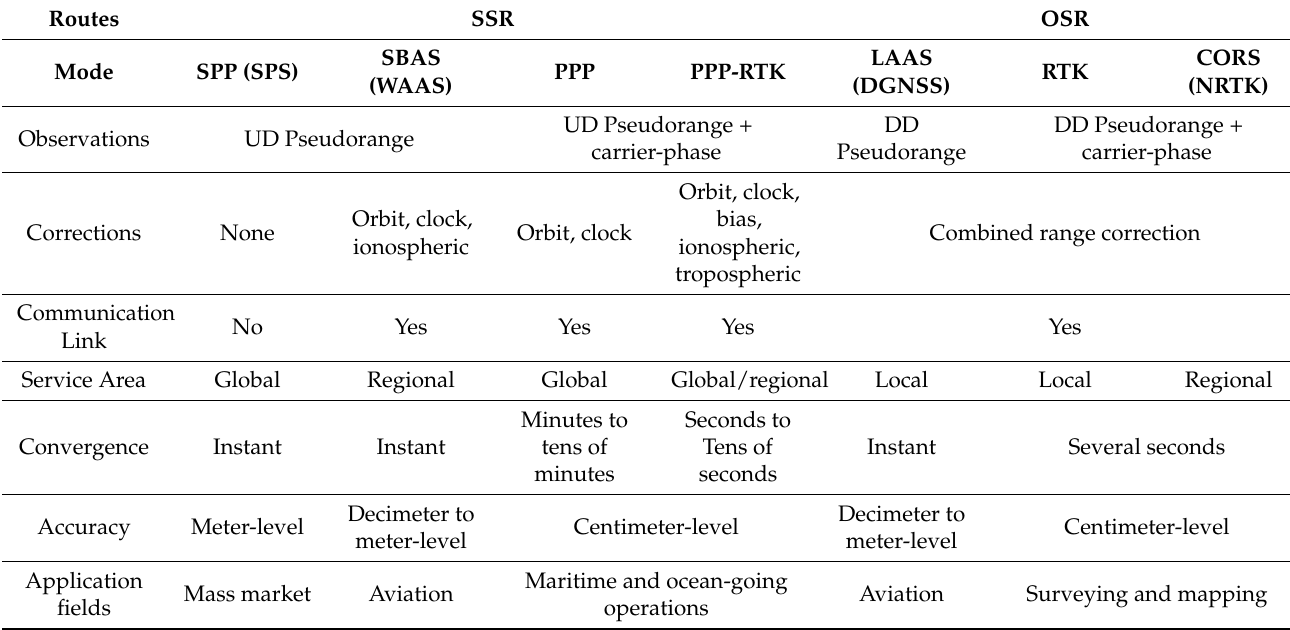
Table 1. Comparison of most widespread GNSS positioning technologies based on SSR and